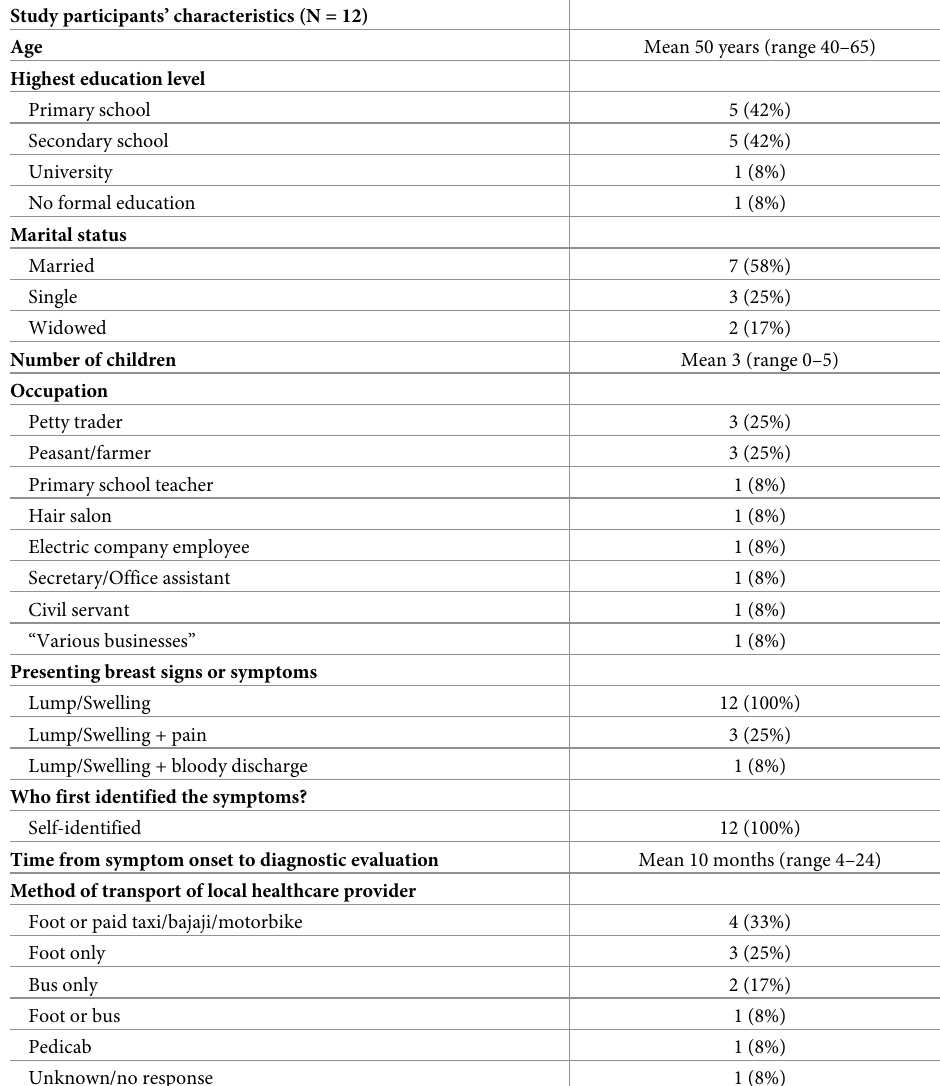
Table 1. Study participants’ characteristics (N =